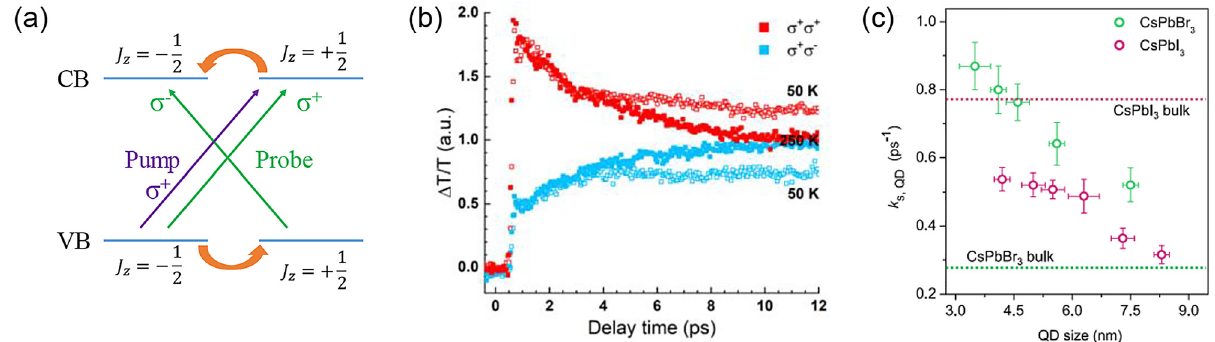
Figure 13: (a) Schematic of optical transitions between valence and conduction band states induced by circularly polarized light. (b)Normalized polarization-dependentTA tracesrecordedfromtheCsPbI 3 nanocrystalsat 50 and250K,respectively.(a)and(b)Adaptedand reproduced with permission [166]. Copyright 2020, American Chemical Society. (c) Size dependent spin-relaxation rate for CsPbI 3 (red) and CsPbBr 3 (green) nanocrystals. The red and green dashed lines are values for bulk counterparts, respectively. Reproduced with permission [167]. Copyright 2020, American Chemical